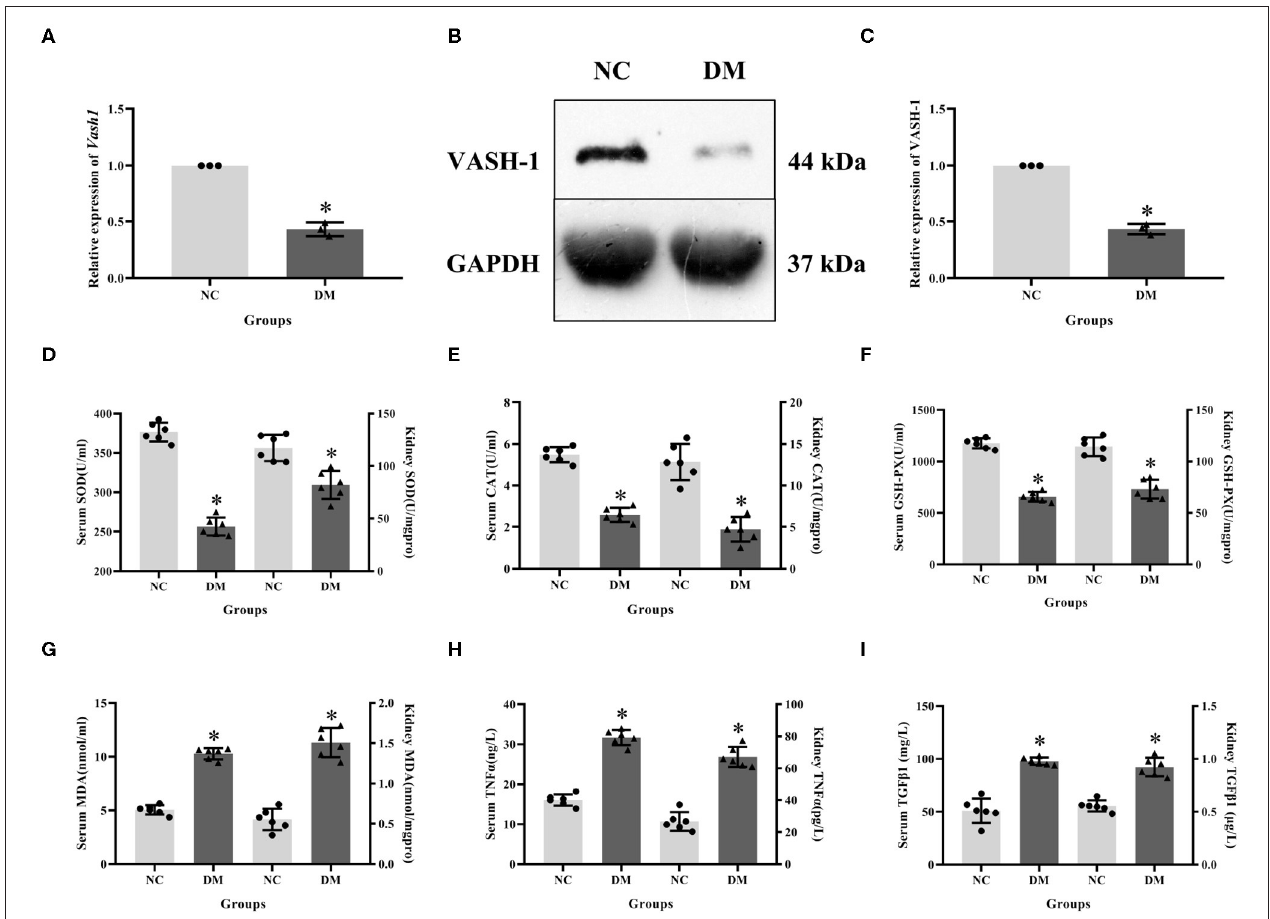
FIGURE 3 | Molecular biology results in diabetic rats. (A) relative expression of Vash1 mRNA, (B) western blot protein band, (C) relative expression of VASH-1 protein, (D) SOD, (E) CAT, (F) GSH-PX, (G) MDA, (H) TGF α , (I) TGF β 1 in serum and kidney tissues. *Compared with the NC group, P < 0.05. Data were expressed as mean ± SD, and experiments were repeated three